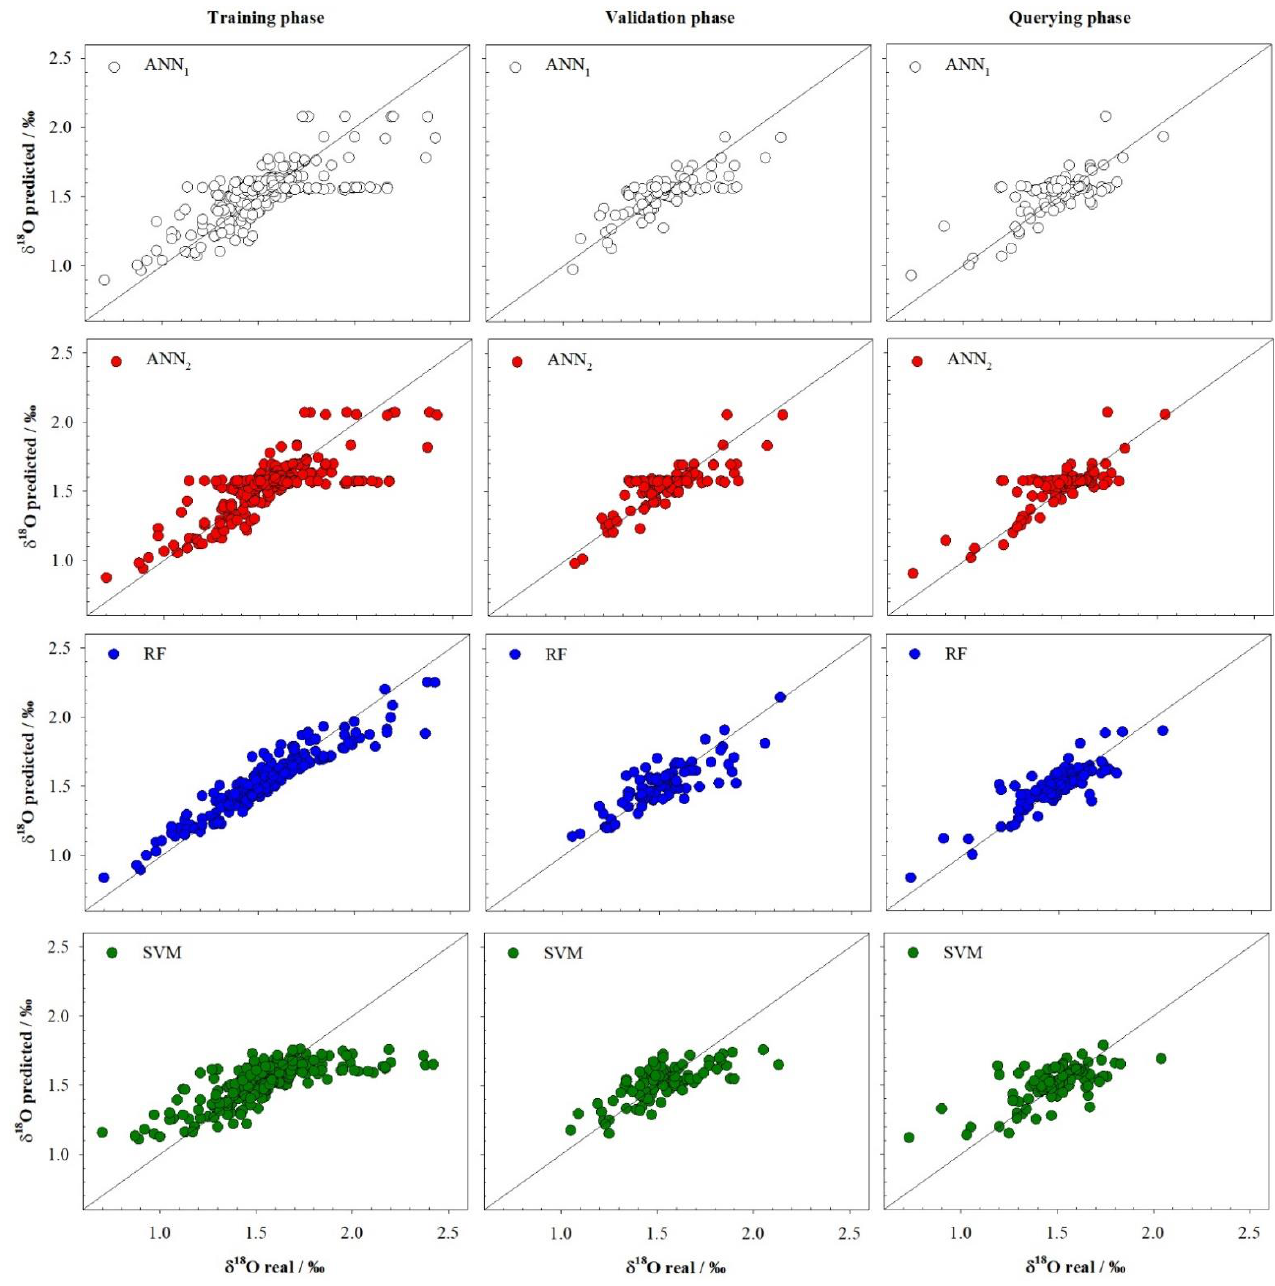
Figure 1. Real values vs. predicted values for δ 18 O (‰) by artificial neural models ANN 1 and ANN 2 , random forest model (RF) and support vector machine model (SVM) developed. The black lines correspond to the line with slope one.